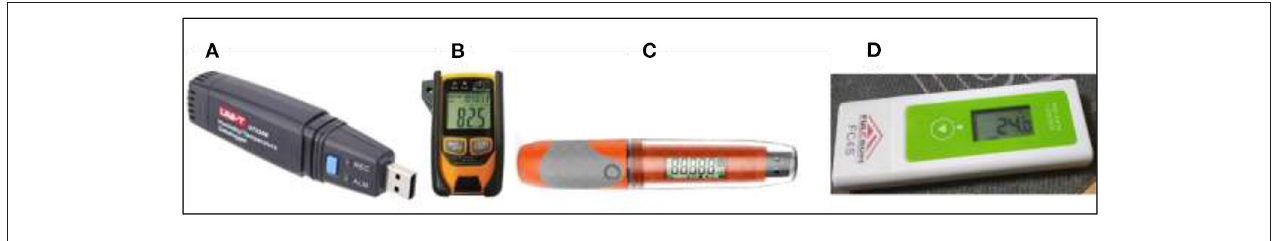
FIGURE 1 | Temperature and humidity data loggers used for indoor measurements. (A) UNI_T temperature and humidity data logger, (B) HTC Easy Log humidity/temperature data logger, (C) Elitech RC-51 High Accuracy USB Temperature Data Logger, and (D) Fulcrum temperature and humidity pdf data logger.